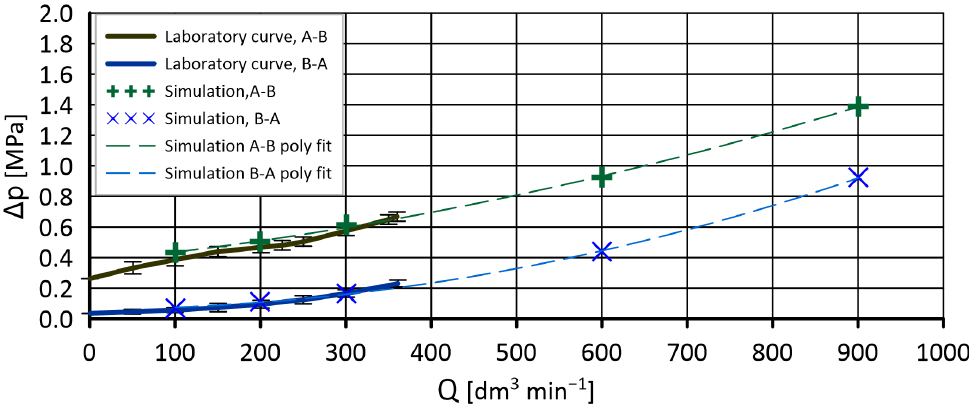
Figure 21. Comparison of the pressure drop on the check valve from numerical simulations and laboratory tests as a function of flow rate; vertical markers—standard